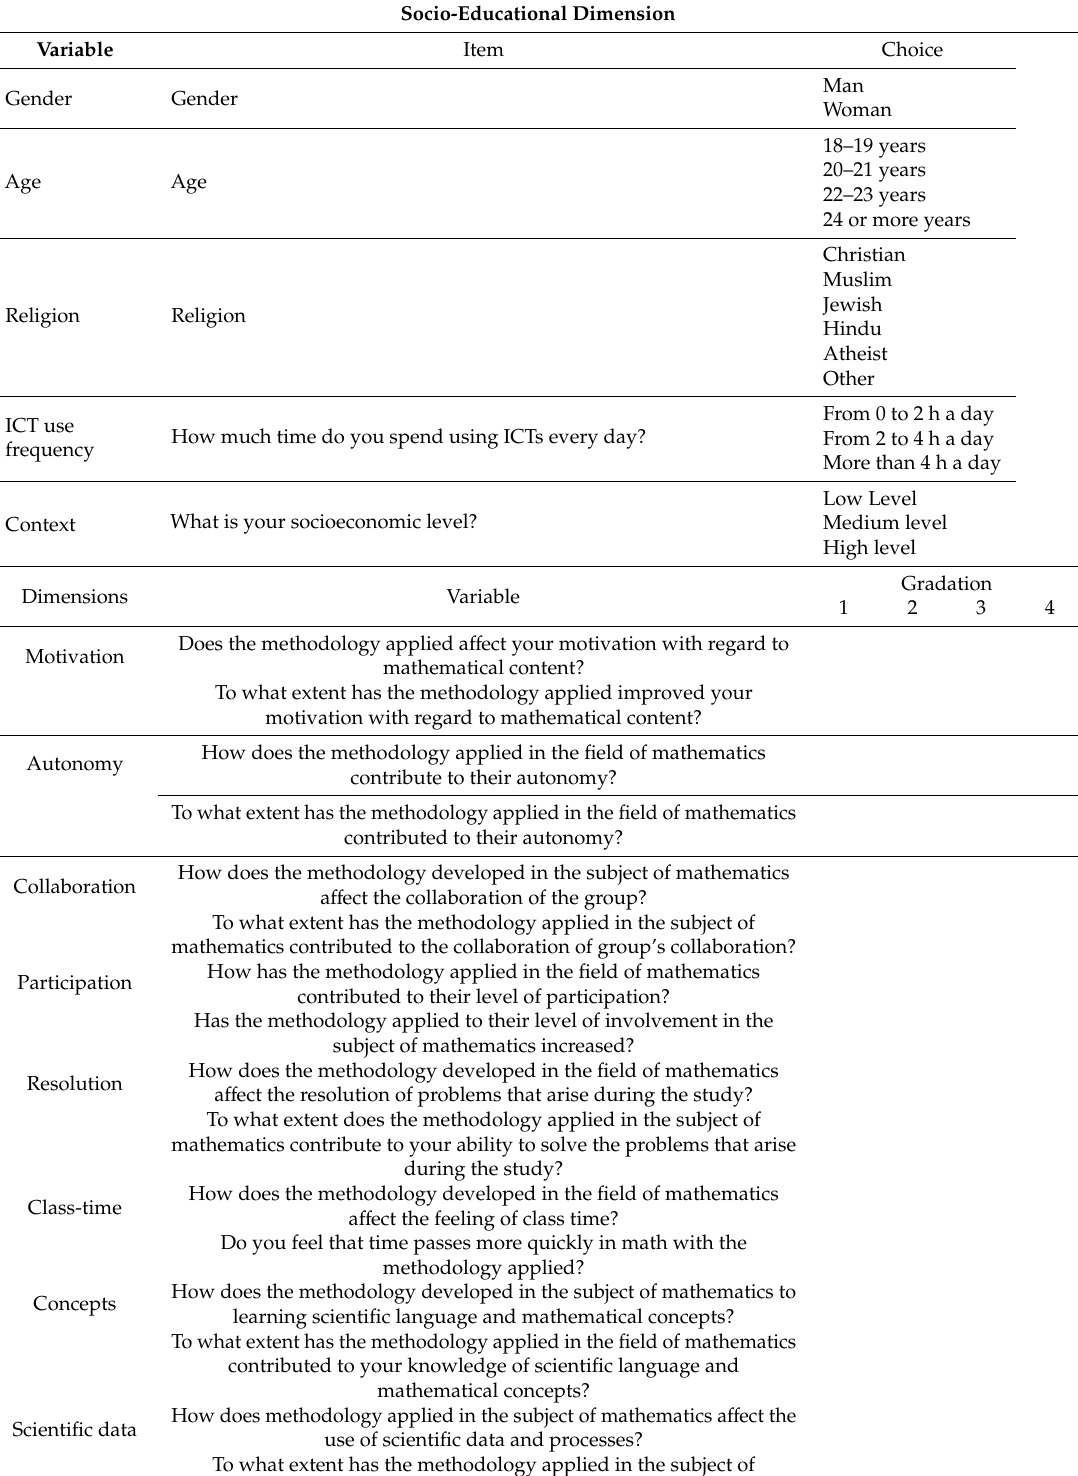
Table A1. The instrument used is an ad hoc